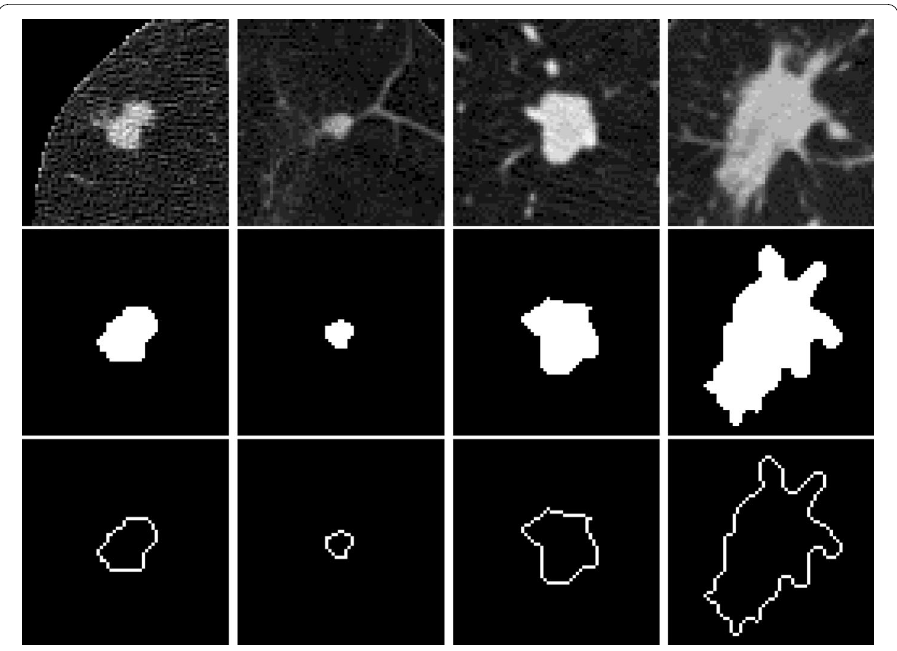
Fig. 9 Pulmonary nodules images, ground truth images and boundary images (top to